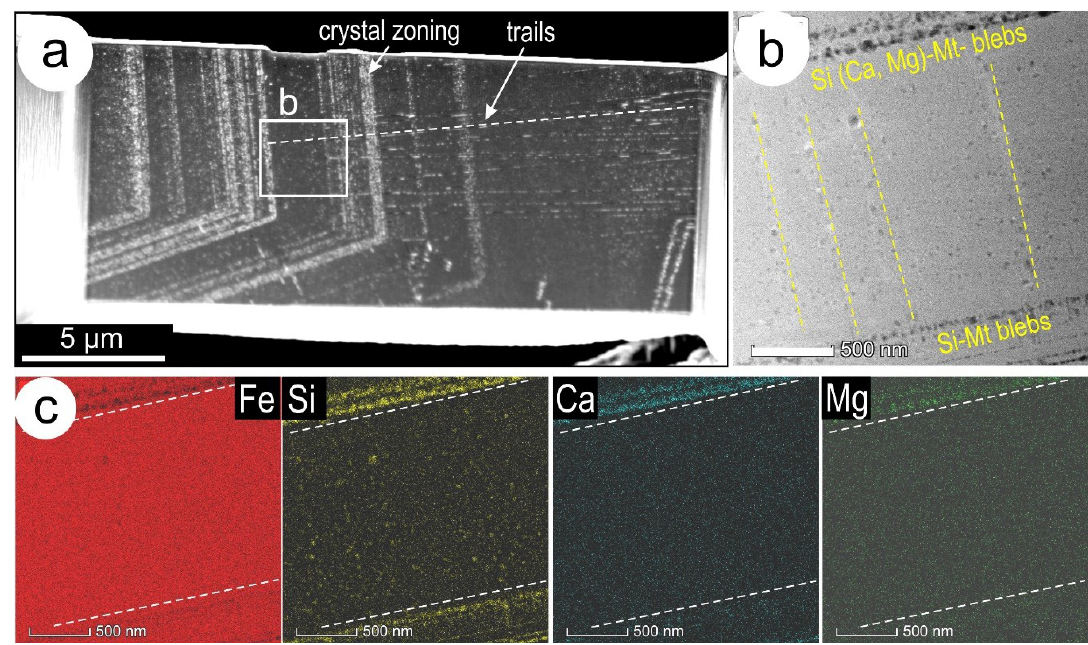
Figure 5. ( a ) Bright Field (BF) STEM image showing crystal zoning and crosscutting trails in medium-sized grains of magnetite (Mt) (foil #2). ( b , c ) HAADF STEM and EDS maps showing variation in band composition for an area marked in (a). Note Ca and Mg are measured only in the top bands whereas the bottom bands are only Si, Fe-bearing corresponding to silician magnetite nanoprecipitates (Si–Mt) blebs. Note also that the bright inclusions present along the trails (dashed lines) are not depicted by the elemental maps at this resolution. The two bands with different chemistry are highlighted by white dashed lines on the maps.